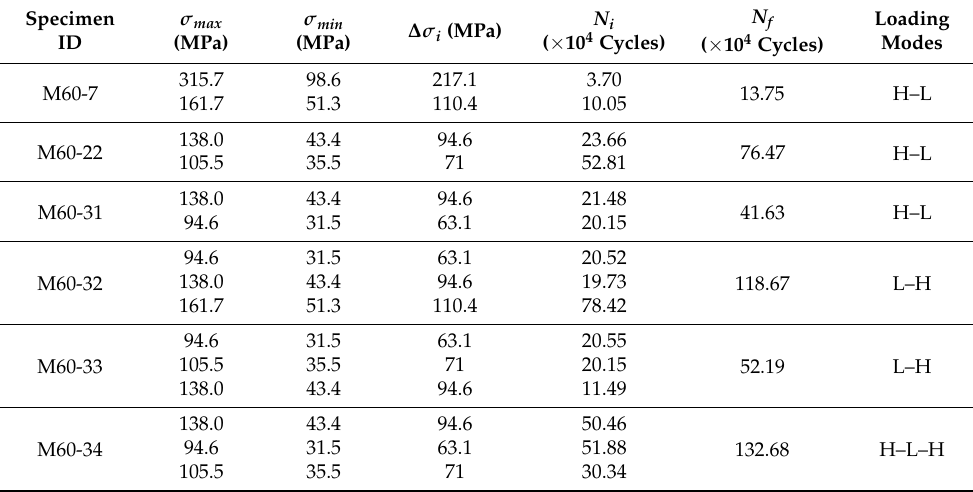
Table 2. The variable-amplitude fatigue test results of the M60 high-strength